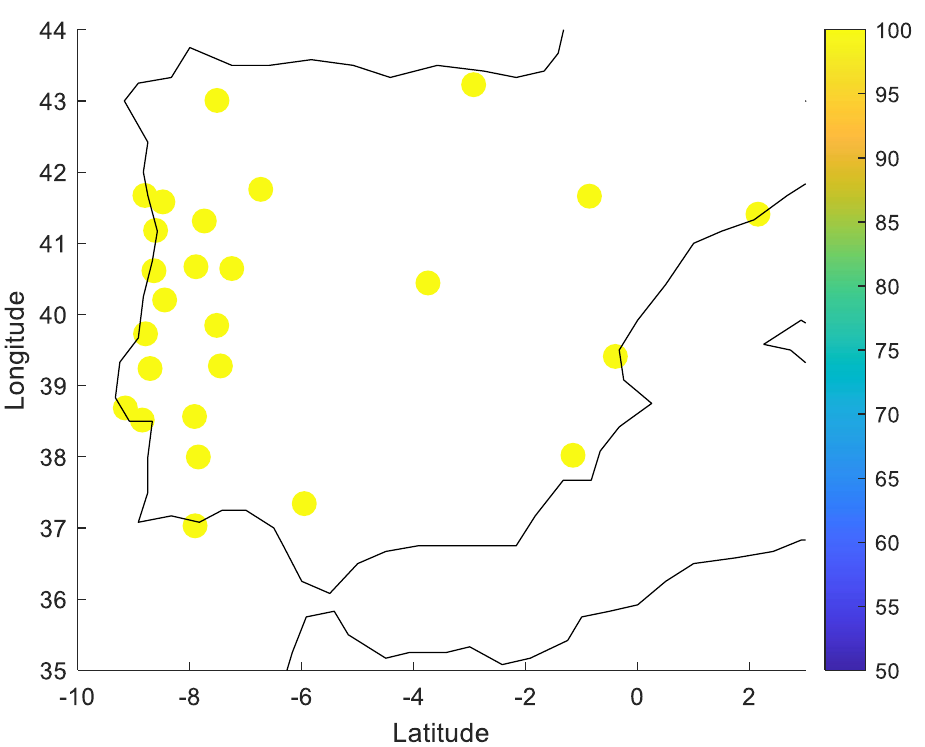
Figure 6. Average percentage of time for the July–September period that 300 hPa wind speed di ff erences, future minus historic, are negative.